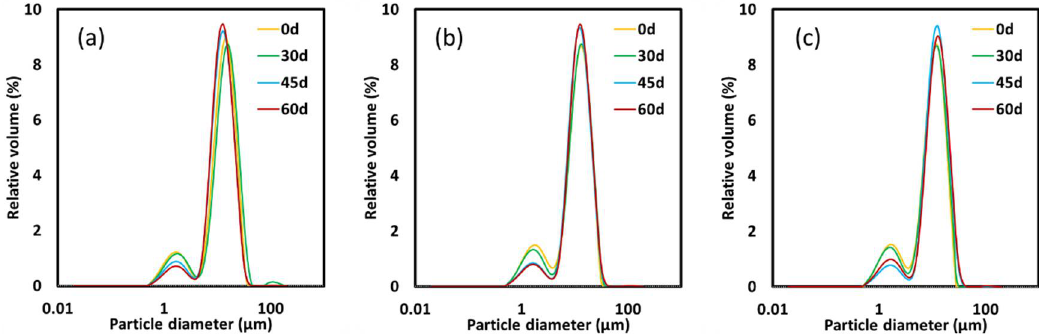
Figure 1. Droplet-size distribution of ( a ) EΦ65%, ( b ) EΦ70%, and ( c ) EΦ75% during 60 days of storage at 25 °C.